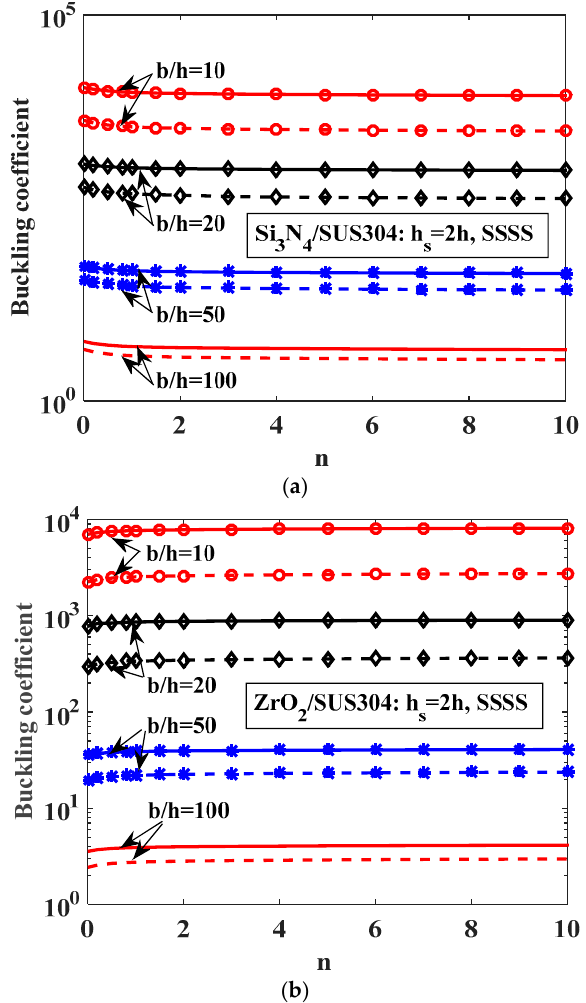
Figure 6. Variation of buckling coefficient of FGM plate with one central stiffener and without stiffeners (solid line: plate with one central stiffener, dash-dot line: plate without stiffeners). ( a ) Si 3 N 4 /SUS304; ( b ) ZrO 2 /SUS304.